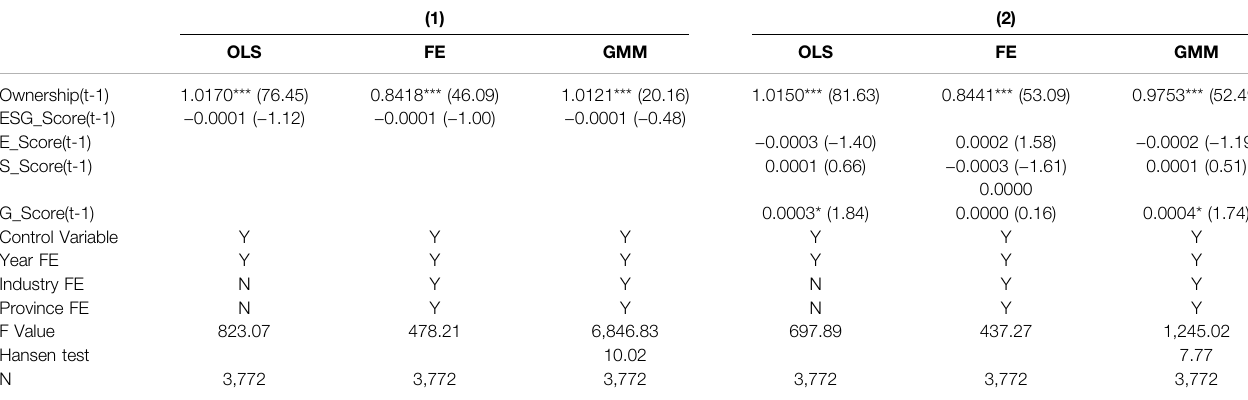
TABLE 4 | Results of dynamic panel system GMM regression (dependent variable: equity ownership held by